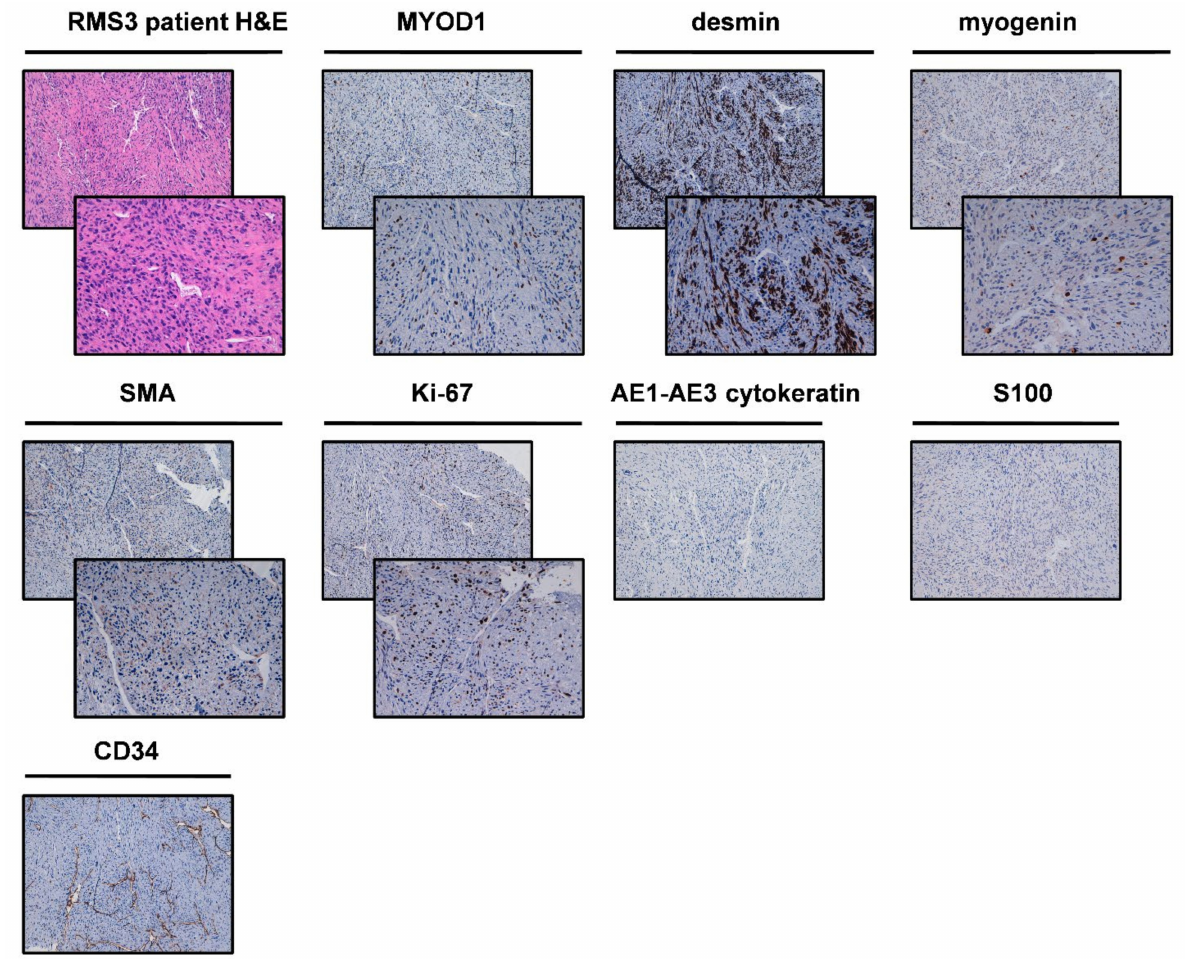
Figure 4. RMS3 patient histological and immunohistochemical analyses. H&E of the patient surgically resected tumor specimen. IHC analysis was performed on patient surgically resected tumor specimen for the following markers: MYOD-1, desmin, myogenin, SMA, CD34, AE1-AE4 cytokeratin, MDM2, S100, STAT6, and ALK. For each marker, upper panels represent 10 × magnification, and lower panels represent magnification 20 × (negative markers are represented with only 10 ×